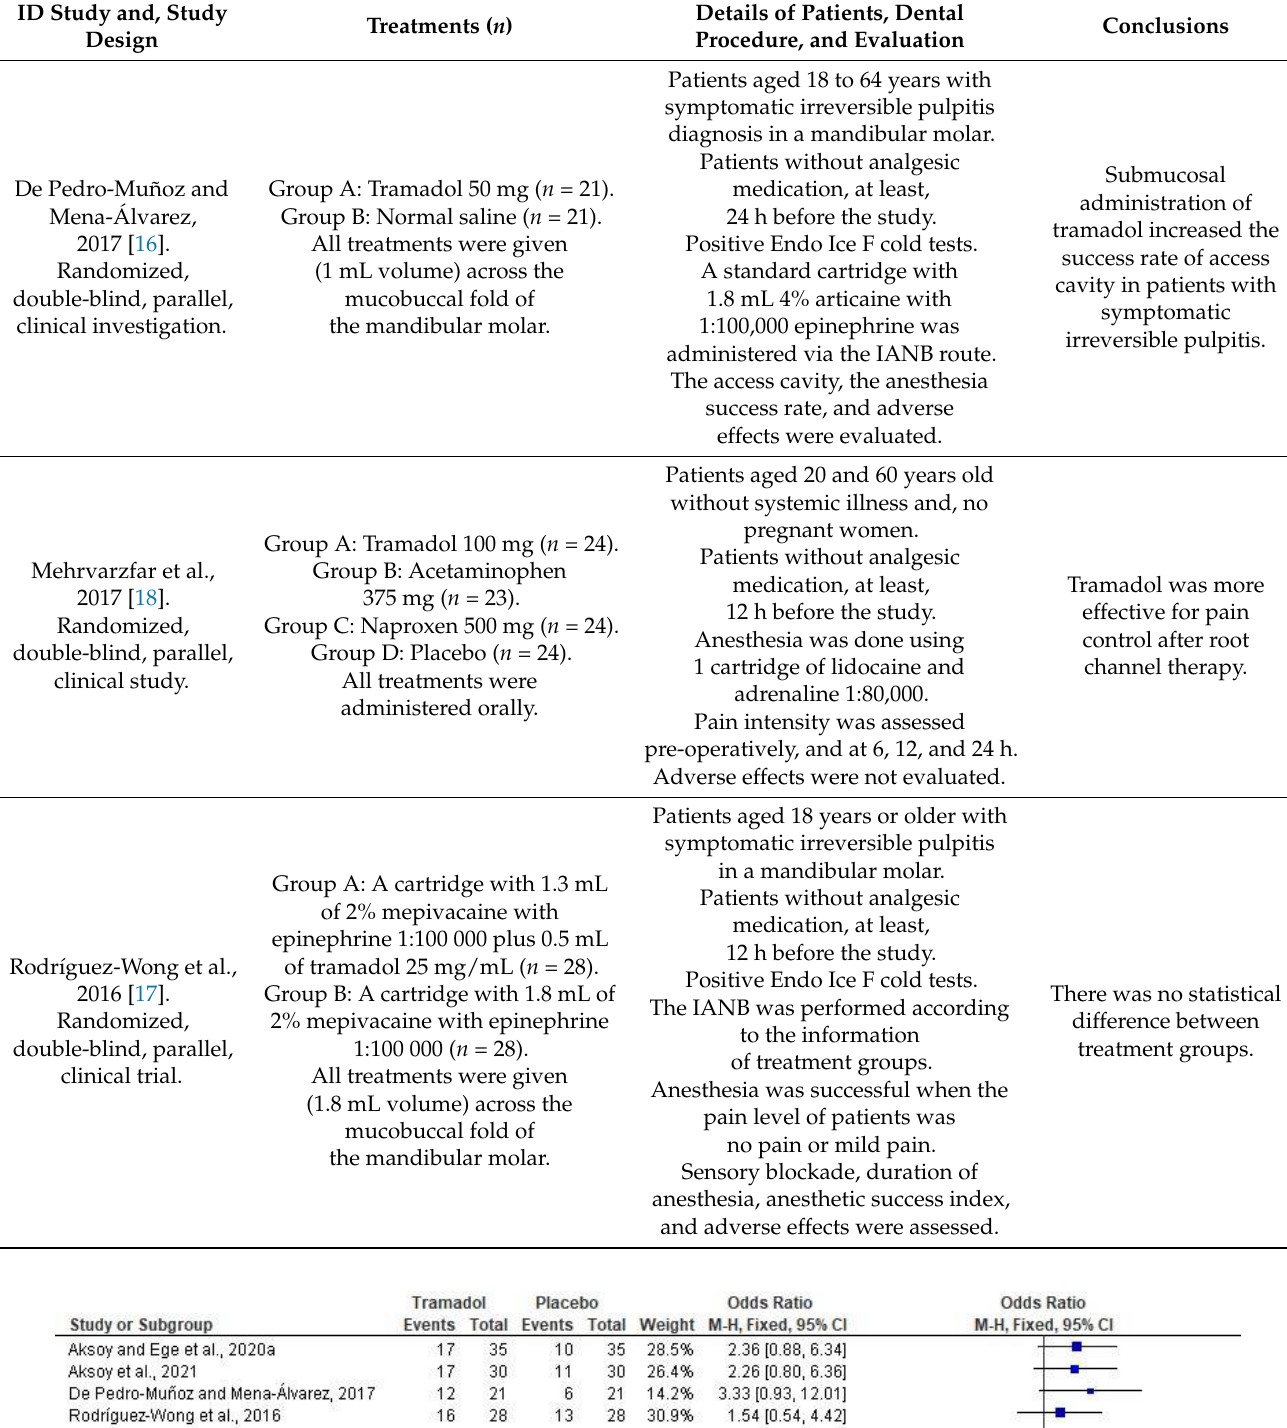
Figure 4). Figure 4. Pooled analysis on adverse effects of local tramadol and placebo/local anesthetics. 4.4. The Publication Bias The publication bias of the published clinical investigations was evaluated using the data of anesthetic success (Figure 5A) [13,15–17] and pain control (Figure 5B) [13–17] of tramadol and placebo/local anesthetic in patients with SIP. In both cases, the data fell within the funnel plot, indicating a low risk of publication bias.